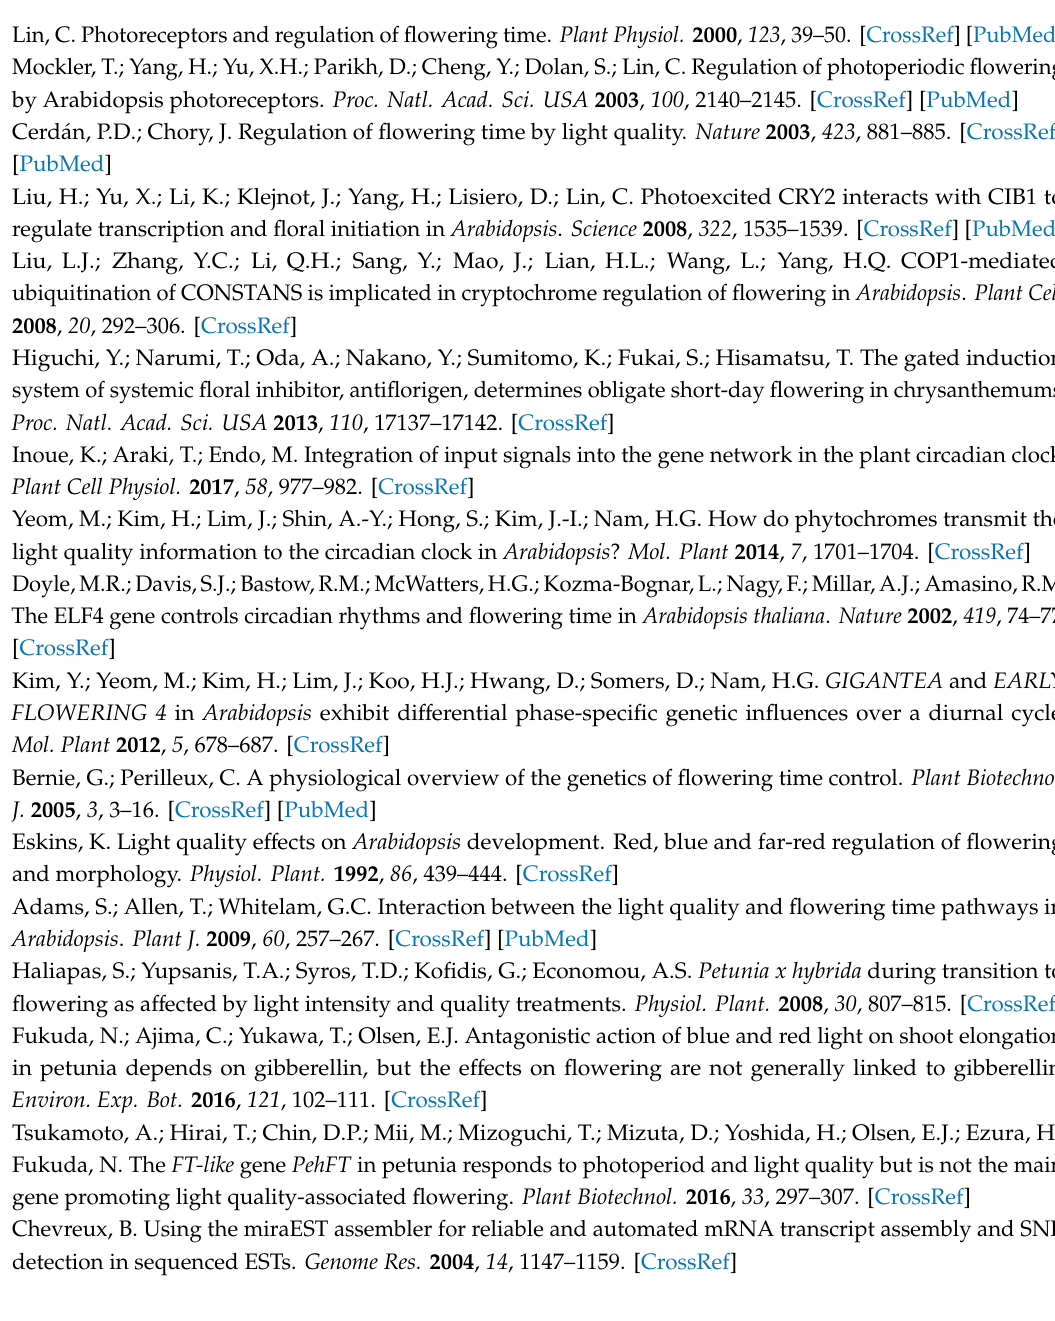
Figure S1: Irradiation and spectral distribution of the light sources used in this study. (A) White fluorescent lamp. (B) Blue light emitting diodes (LED). (C) Red LED, Figure S2: cDNA sequences of PhELF4-1 (A) and PhELF4-2 (B) in